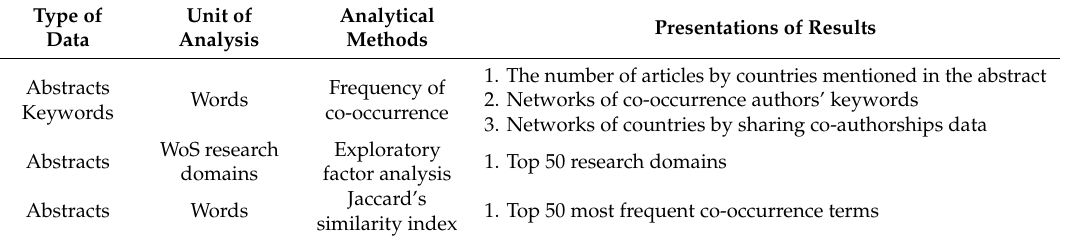
Table A1. Summary of the techniques and